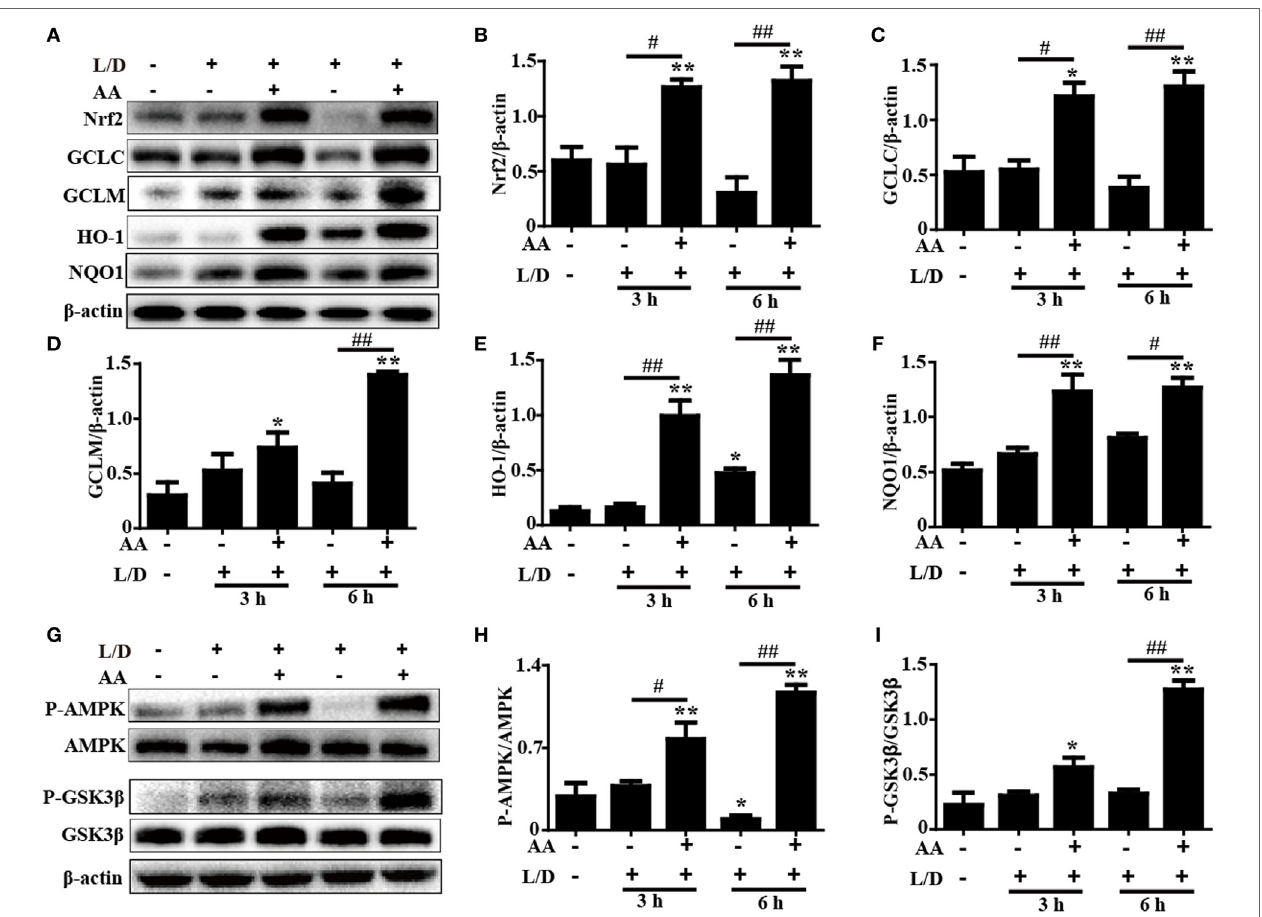
FigUre 5 | Effects of Asiatic acid (AA) treatment on the Nrf2 and AMP-activated protein kinase (AMPK)/GSK3 β signaling pathways in L/D-induced fulminant hepatic failure. Liver tissues were collected from the mice at 3 or 6 h after L/D challenge, liver tissues were collected, and analyzed by Western blotting. (a,g) Effects of AA on Nrf2, glutamate-cysteine ligase catalytic (GCLC), glutamate-cysteine ligase modifier (GCLM), heme oxygenase-1 (HO-1), NQO1, P-AMPK, and P-GSK3 β protein expression. (B–F,h,i) Quantification of relative protein expression was performed by densitometric analysis. β -actin was acted used as an internal control. Similar results were obtained from three independent experiments. All data are presented as means ± SEM ( n = 5 in each group). * p < 0.05 and ** p < 0.01 vs. control group; # p < 0.05 and ## p < 0.01 vs. L/D